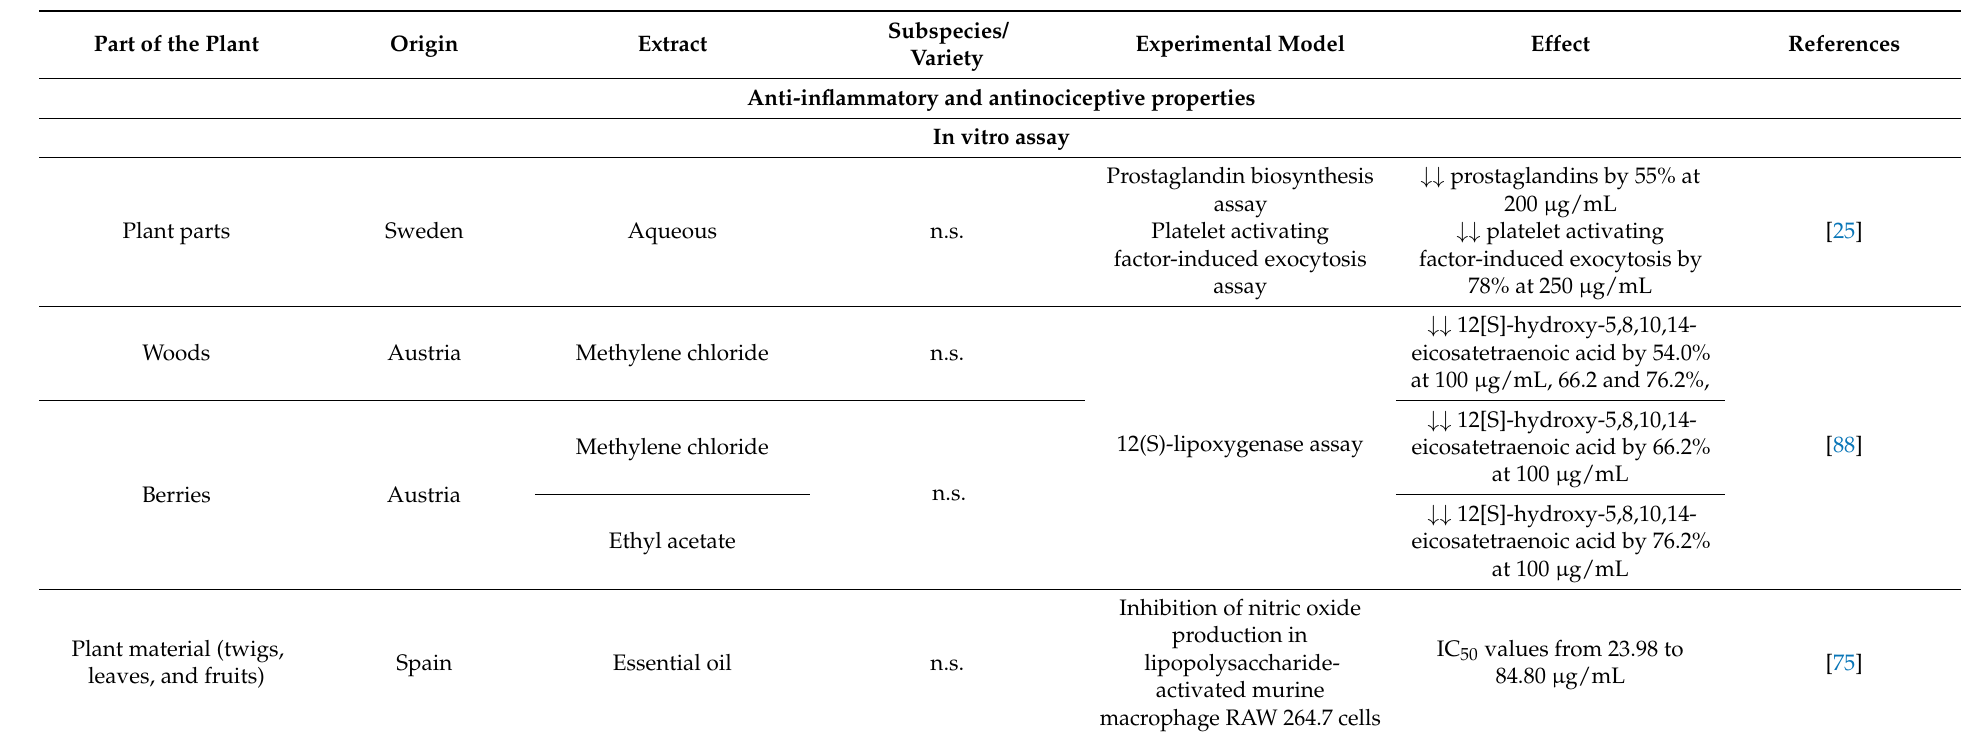
Table 4. In vitro and in vivo health benefits of Juniperus communis